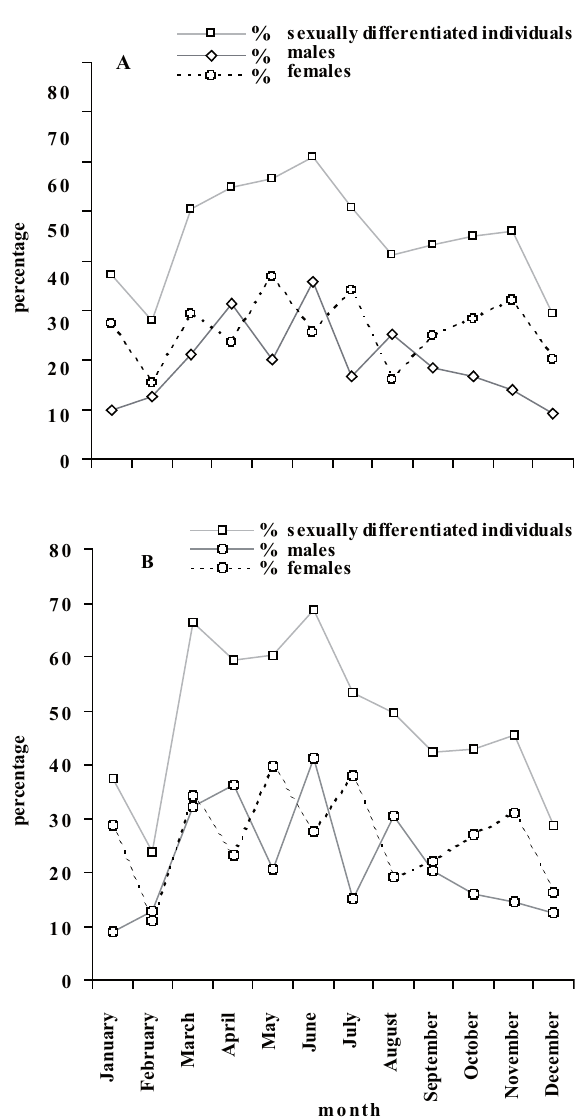
Fig . 5. – Monthly proportion of sexually differentiated individuals, females and males from January to December 2005. A: Pointe-Pes- cade, B: